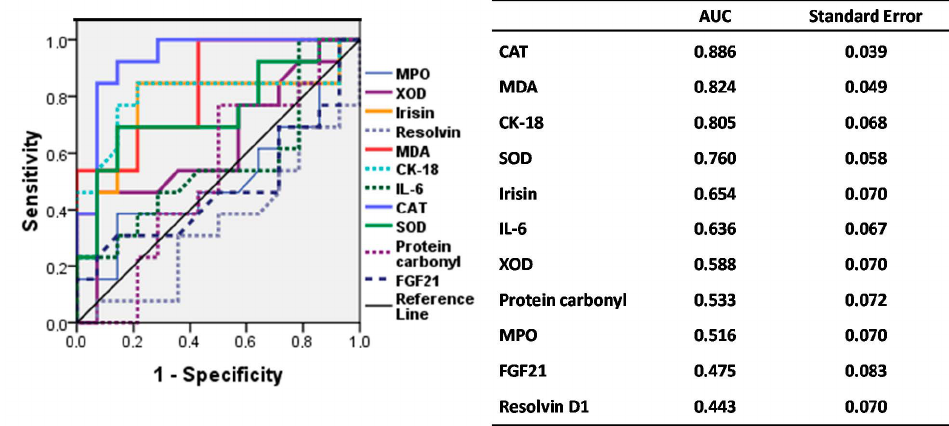
Table 3. Association of biomarkers and intrahepatic fat content (IFC).